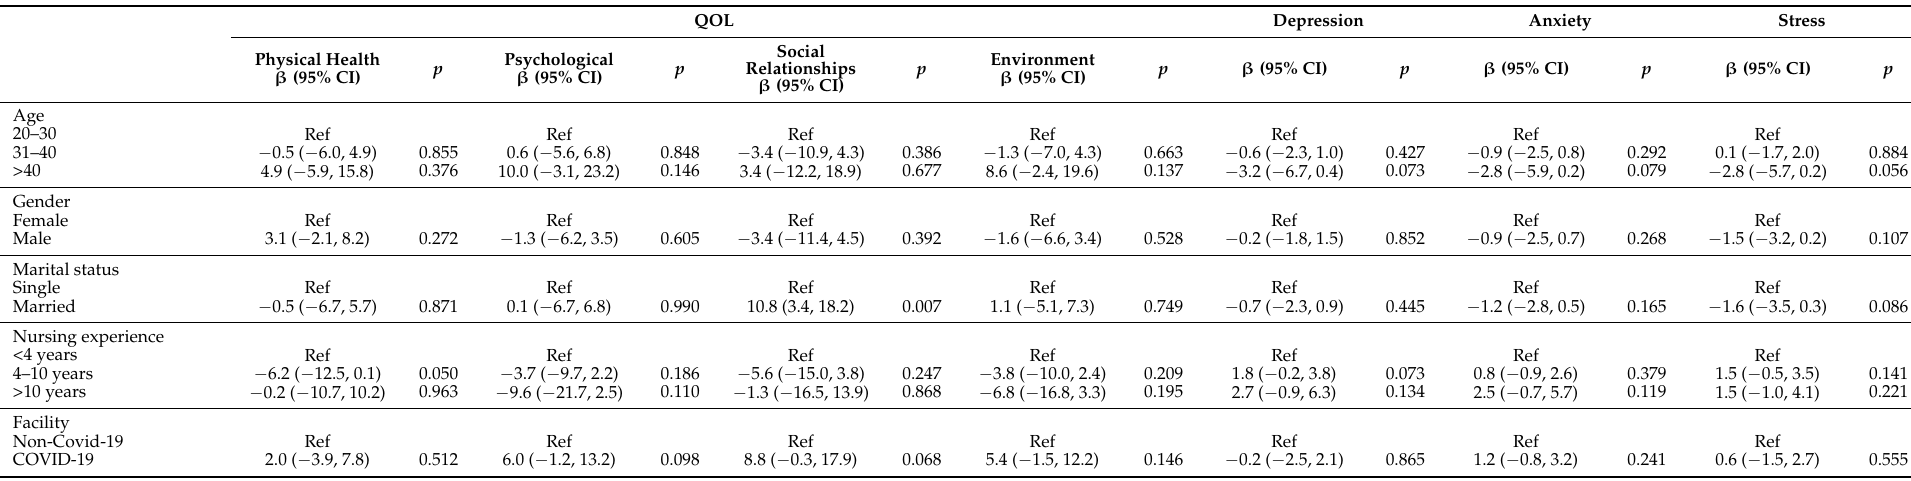
Table 3. Adjusted associations between characteristics of nurses and QOL domains, depression, anxiety, and stress scores. QOL